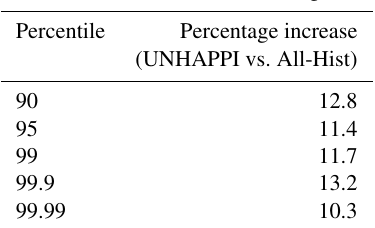
Table 6. Scaling relationships for extreme AR precipitation at var- ious percentiles in California. The increase in SST off the coast of California between All-Hist and UNHAPPI is 1.3K, which corre- sponds to a CC scaling of 9.1%. Note that extreme precipitation scales at super-CC